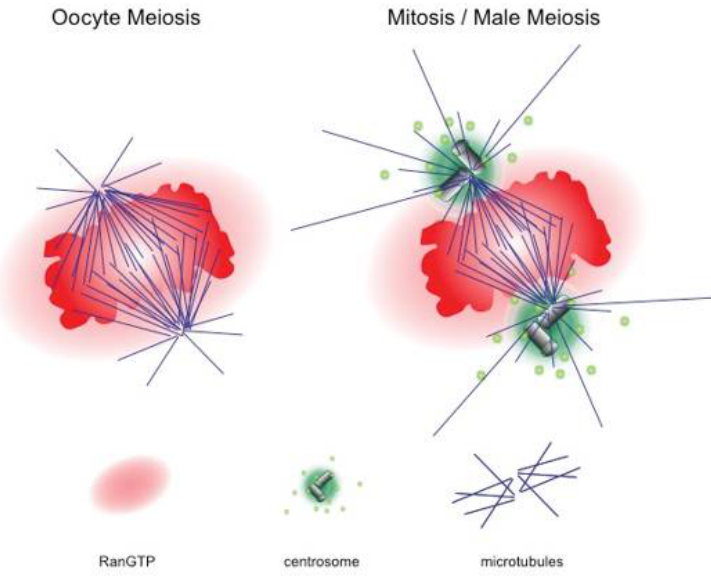
Figure 3. Oocyte meiosis versus mitosis. While spindle formation occurs in the absence of centrosomes in female animal meiosis, mitosis in early cell divisions after fertilisation, mitosis in somatic cells and male meiosis ensues in the presence of two centrosomes as microtubule-organizing centres (MTOCs). In both situations, a high concentration of RanGTP surrounds the chromatin.